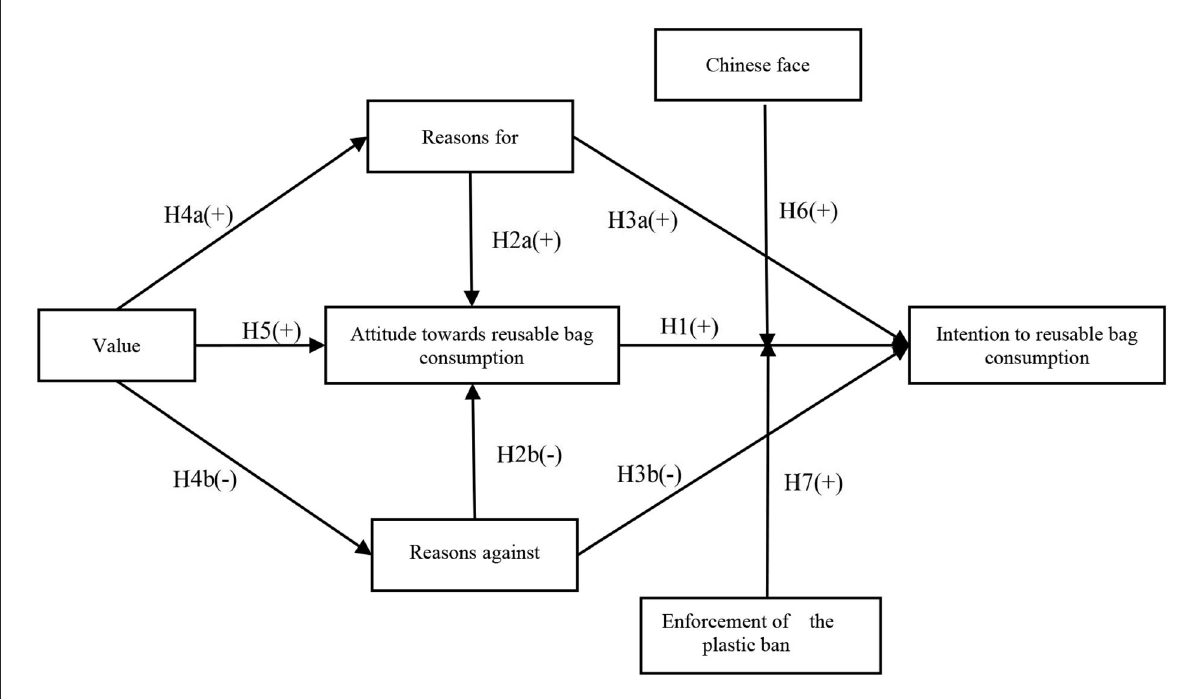
FIGURE1 Research framework